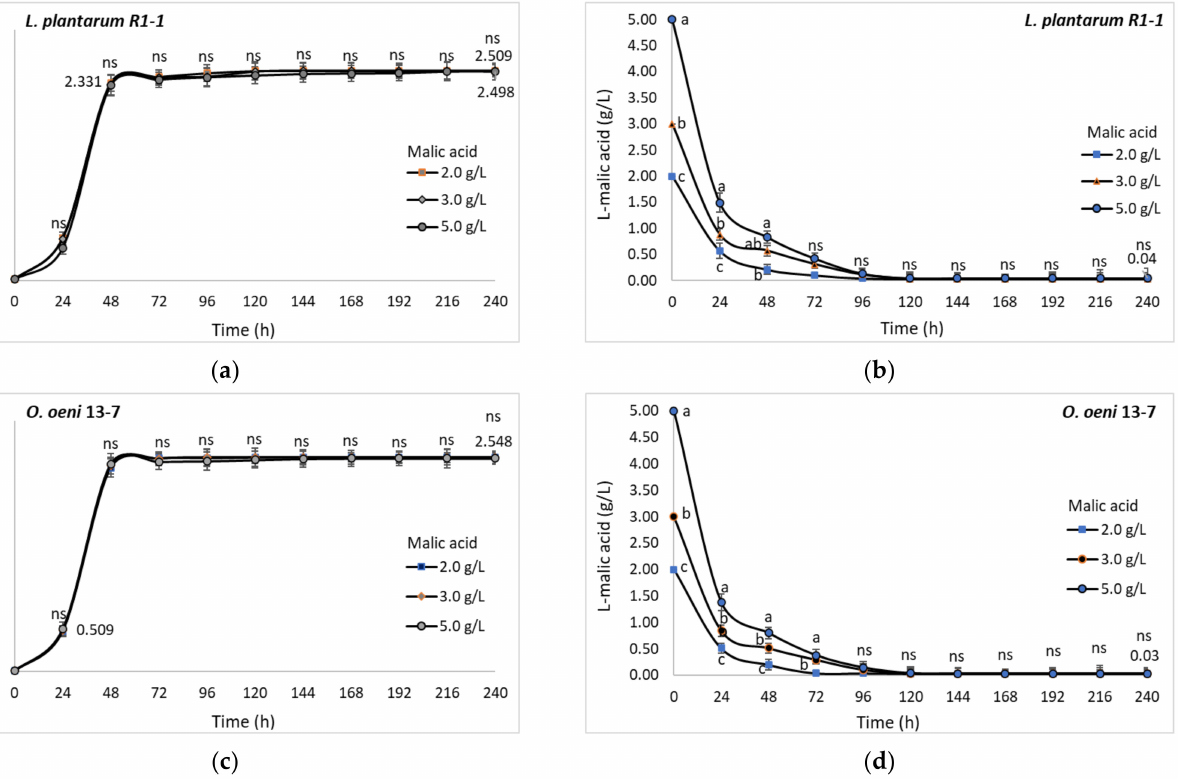
Figure 11. Influence of malic acid concentration on cell development and malolactic capacity of Lactobacillus plantarum strain R1-1 ( a , b ) and Oenococcus oeni strain 13-7 ( c , d ). Cells incubated in MRS- TJ broth (10 6 CFU/mL) at 28 ◦ C. Each value is the mean of a triplicate experiment; error bars indicate standard deviation ( ± ). In all cases the standard deviation was lower than 10% of the mean value. Different letters within the same column indicate significant differences between data ( p <